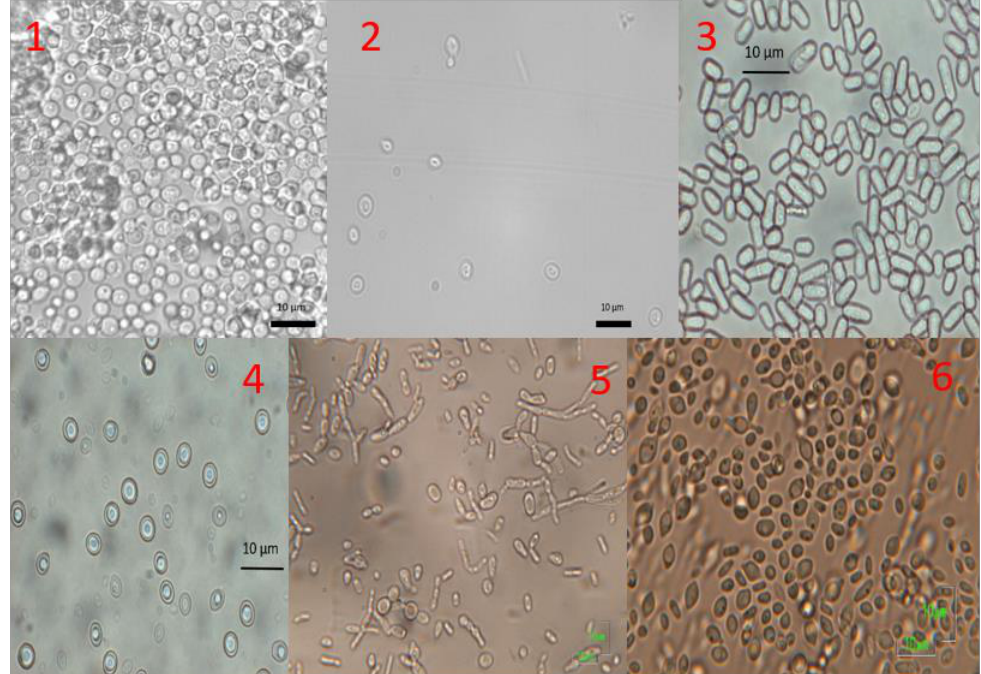
Figure 1. Microscopic observation of Torulaspora delbrueckii ( 1 ), Lachancea thermotolerans ( 2 ), Schizosaccharomyces pombe ( 3 ), Metschnikowia pulcherrima ( 4 ), Meyerozyma guilliermondii ( 5 ) and Hanseniospora uvarum ( 6 ) cells.